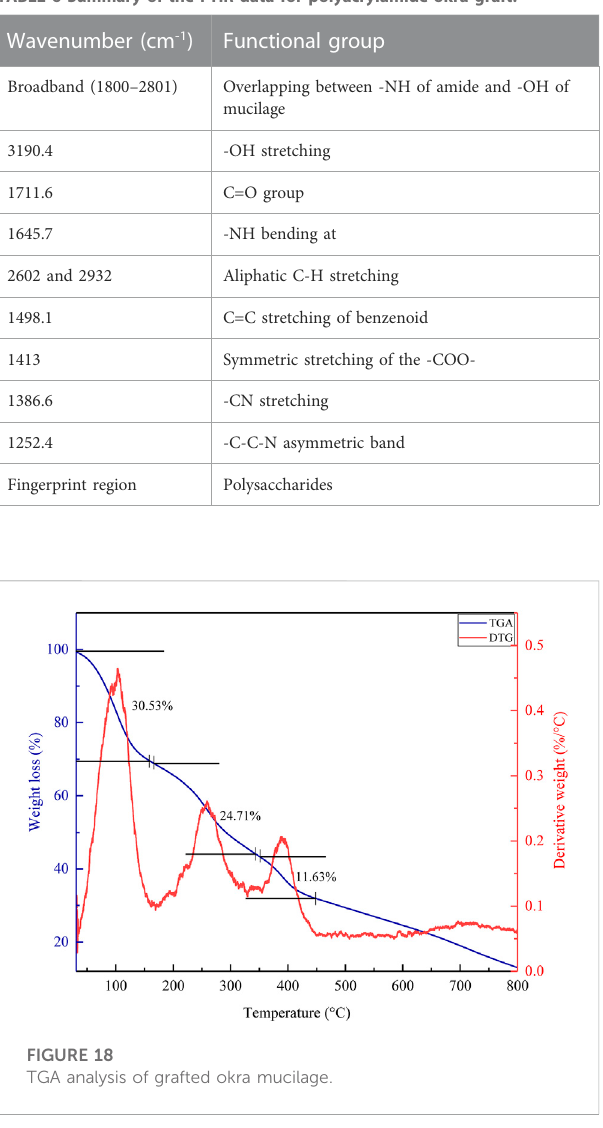
TABLE 6 Summary of the FTIR data for polyacrylamide-okra graft.